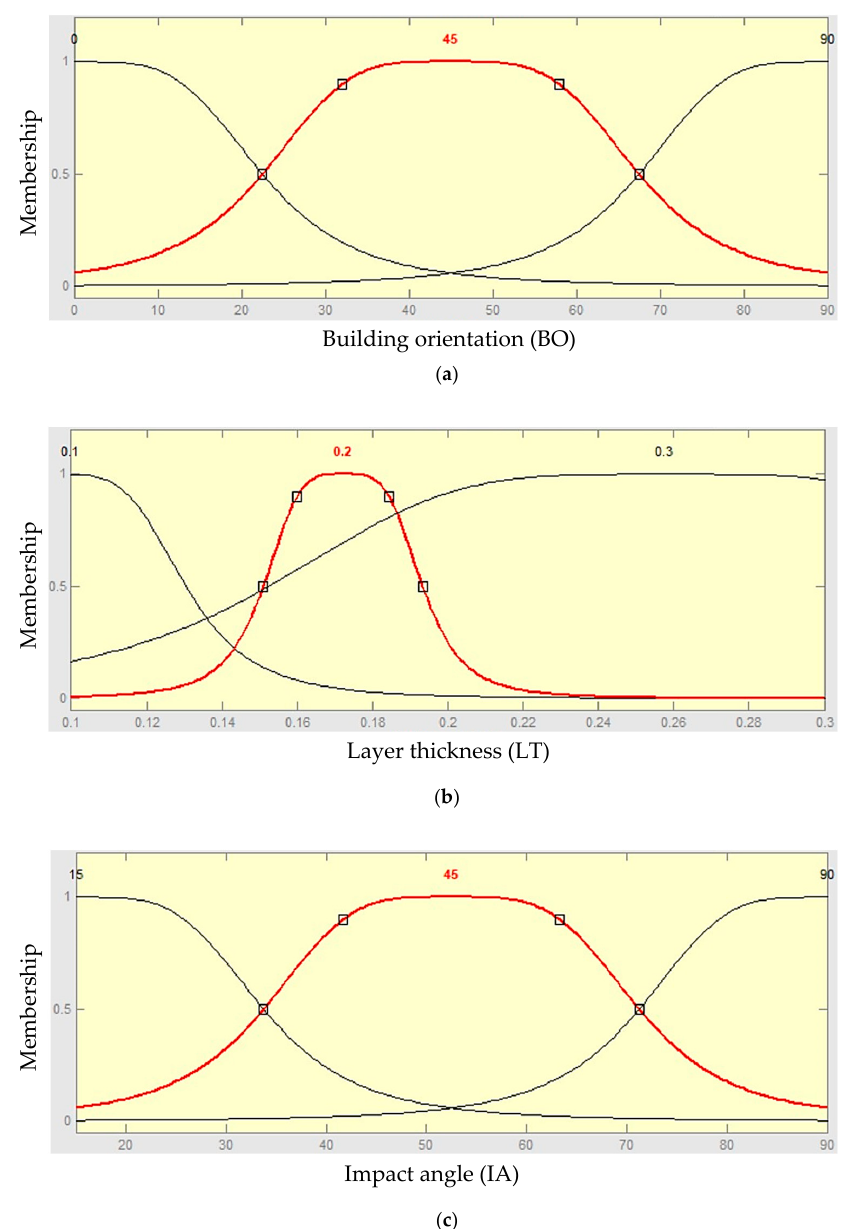
Figure 7. Membership functions of input parameters after training: ( a ) membership function of building orientation (BO), ( b ) membership function of layer thickness (LT), and ( c ) membership function of impact angle (IA). First parameter membership functions: